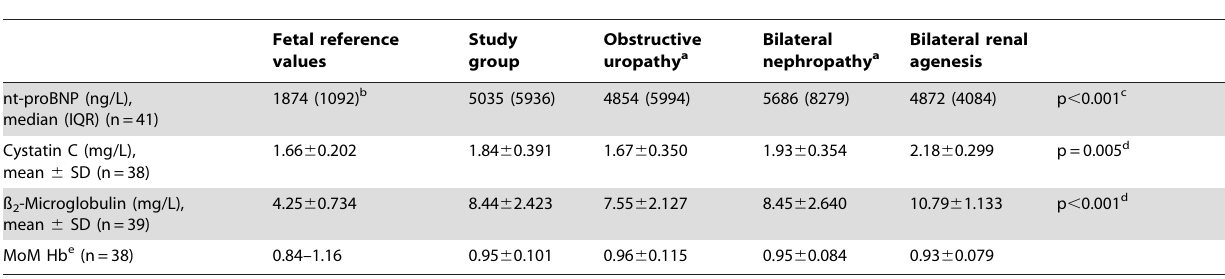
Table 2. Umbilical vein concentrations of cardiac and renal function tests in fetuses with isolated urinary tract malformations.